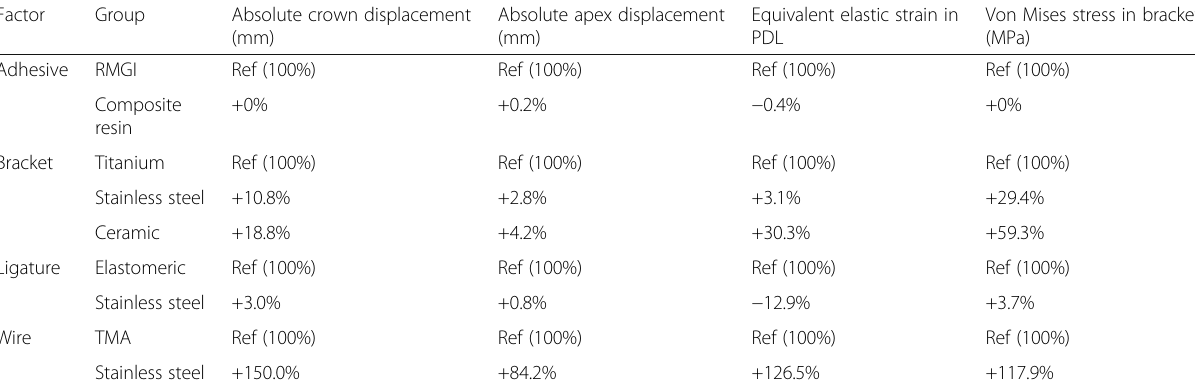
Table 3 Percentage changes in the various models according to the material of each component